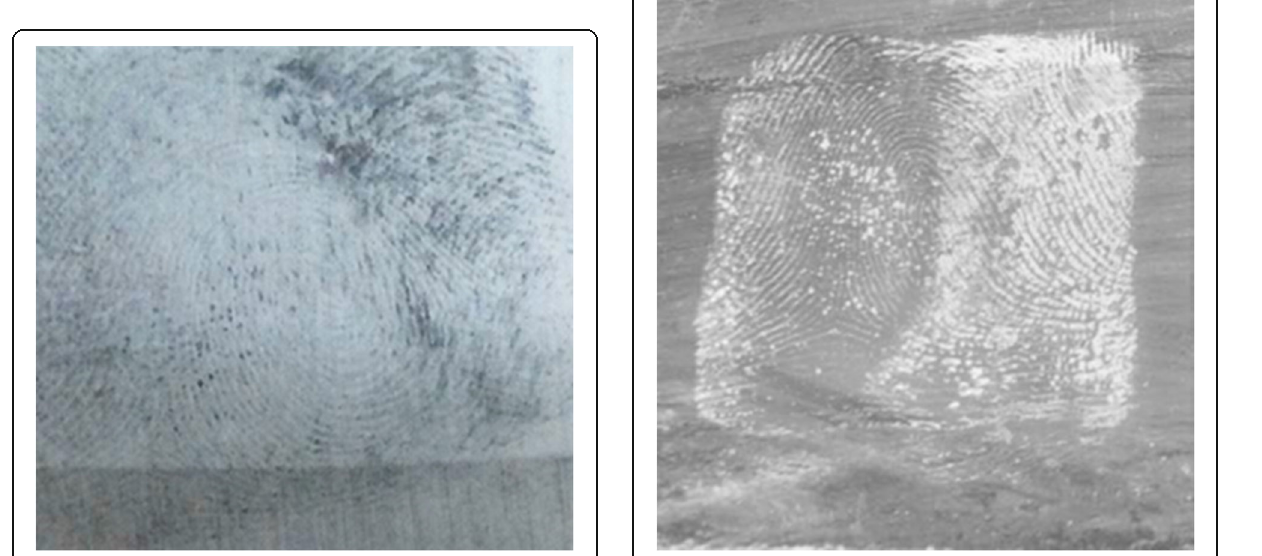
Cyanoacrylate Fuming Compound, 20 g, Sirchie Co.